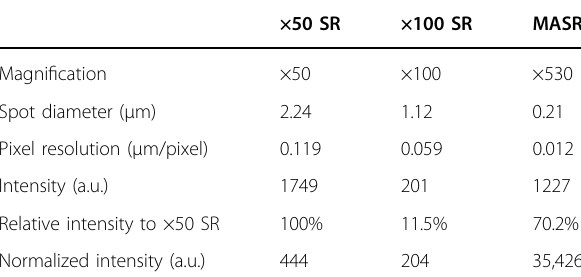
Table 1 Comparison of magni fi cation, pixel resolution, spot diameter, intensity, relative intensity, and normalized intensity of the experimental results. ×50 SR ×100 SR MASR Magni fi cation ×50 ×100 ×530 Spot diameter ( μ